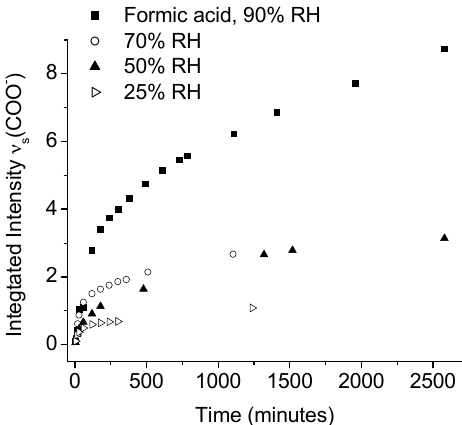
Figure 4. Zinc exposed to formic acid at different relative humidities. The x-axis shows the time and the y-axis the amount of zinc formate formed, as determined by the intensity of the antisymmetric formate stretch. Reproduced from [54] by permission of The Electrochemical Society. Copyright 2006.